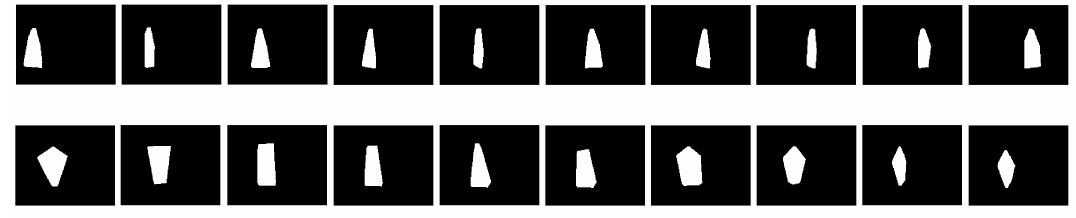
Figure 4. Exemplary preprocessed masks for ‘walk’ ( top row ) and ‘jumping jack’ ( bottom row )